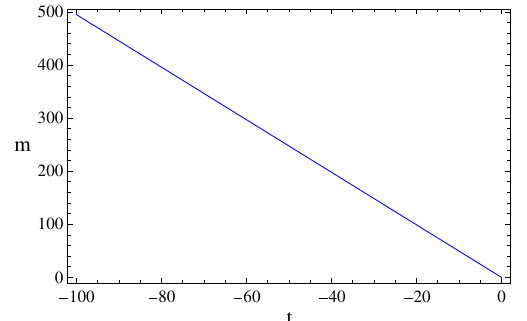
Fig. 4 Mass of the star as a function of time